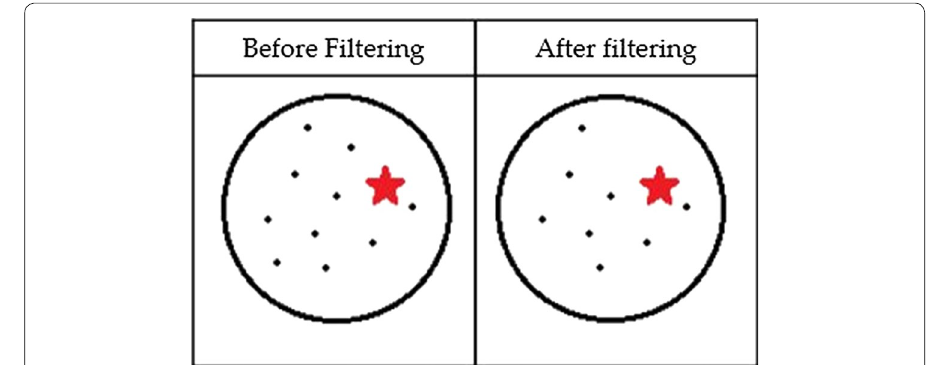
Table 5 Improvement of N